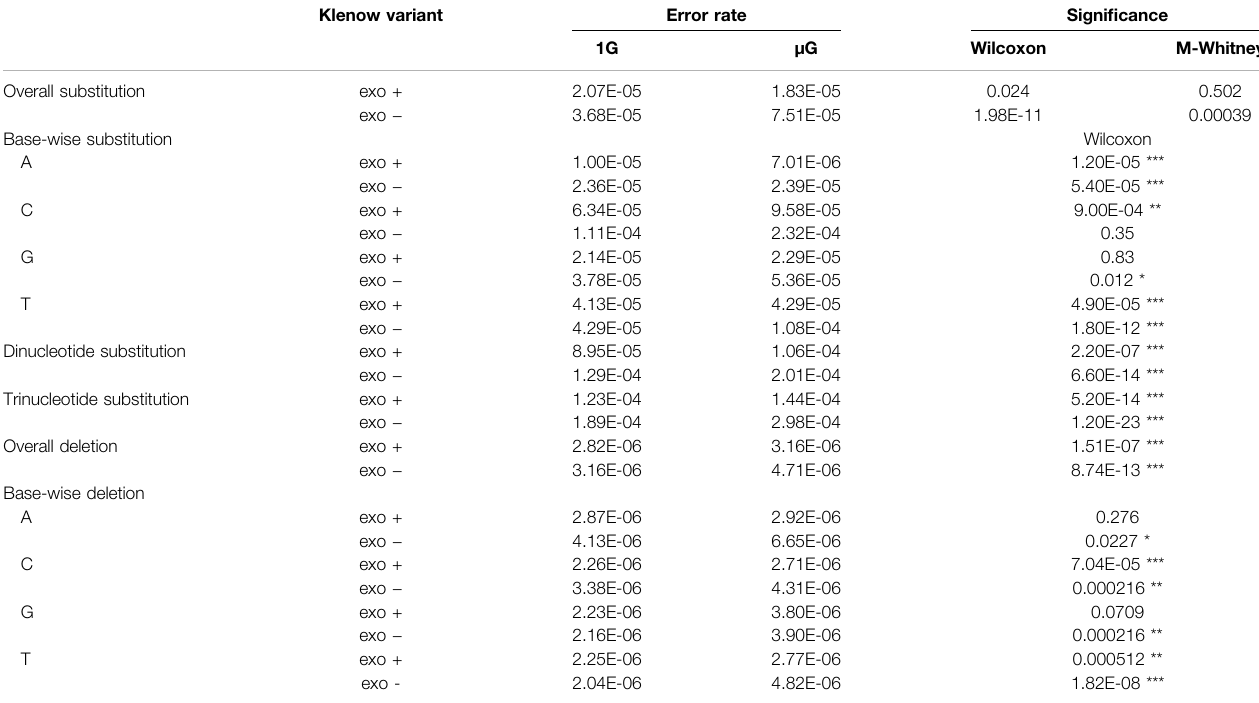
TABLE 1 | Summary of error rates including overall substitution errors, base-wise substitutions distinguished by the template nucleotide either adenine (A), cytosine (C), guanine (G) or thymine (T), di- and trinucleotides, overall deletions, and base-wise deletions grouped by individual template nucleotides (A, C, G or T) for each sample under conditions of either earth-like gravity (1 G) or microgravity ( μ G) in the presence or absence of the Klenow fragment exonuclease activity (exo + or exo-, respectively), with statistical signi fi cance calculated using Wilcoxon signed-rank tests or Mann-Whitney U tests